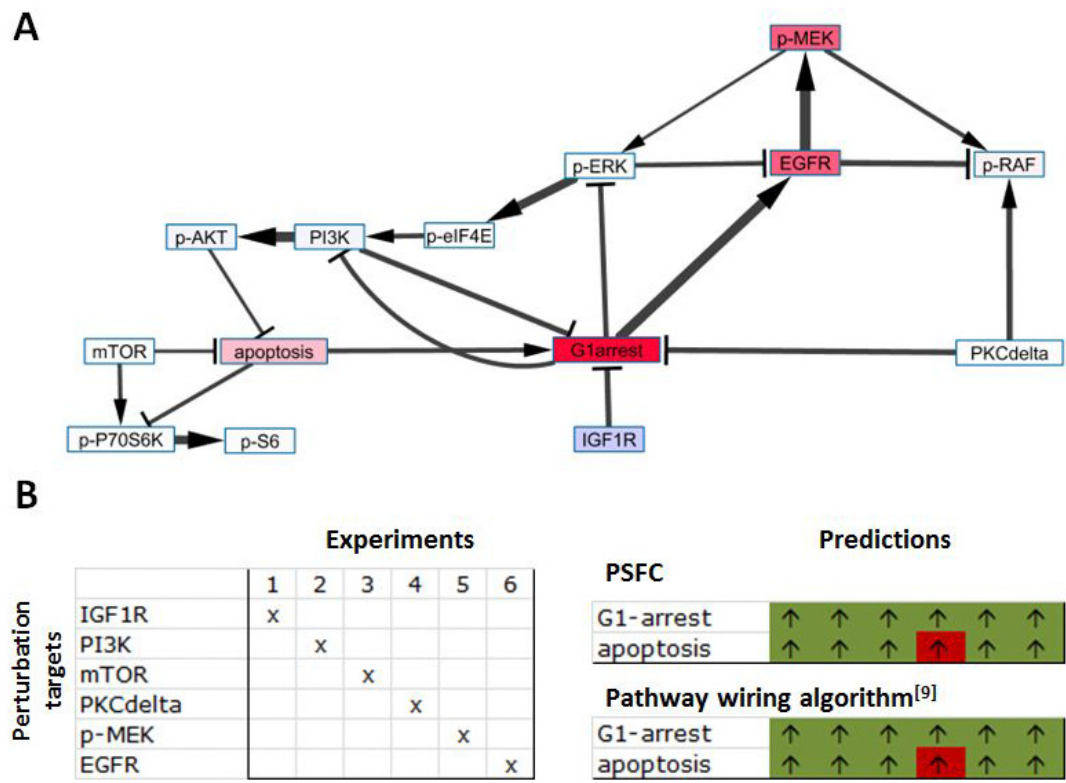
Figure 5. PSF calculation results on MAPK signaling pathway. MAPK signaling pathway is generated by the model used in 8. Part A shows the pathway, as visualized in Cytoscape after PSF calculations. Edges of activation and inhibition types have Delta and T shaped target arrows. The darker colors of nodes indicate greater PSF values, and the line width corresponds to the signal intensities at the edges. The prediction results of six perturbation experiments by PSFC and the pathway wiring algorithm 9 are presented in part B , similar to the representation in 9. In each of the six experiments, one node was down-regulated, as indicated by the “x” sign. The predicted perturbations at the “G1-arrest” and “apoptosis” nodes are shown with up and down arrows. Green and red colors indicate consistency and non-consistency, respectively, of the predictions with the experimental results presented in